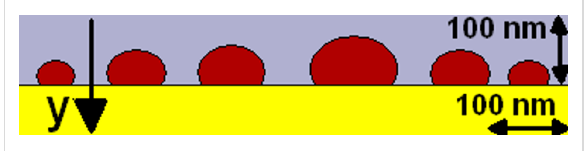
tional grid and cannot be correctly modelled. We have per- formed complementary short simulations with a very limited sample size and with a 2 nm grid, which showed that errors coming from the SiO 2 layer do not exceed 2%. A light source of 460 nm wavelength has been used, propagating along the y axis direction. Two independent simulations were performed, one with a transverse-electric (TE) polarized beam and the second one with a transverse-magnetic (TM) polarized beam. These for the unpolarized beam, according to the